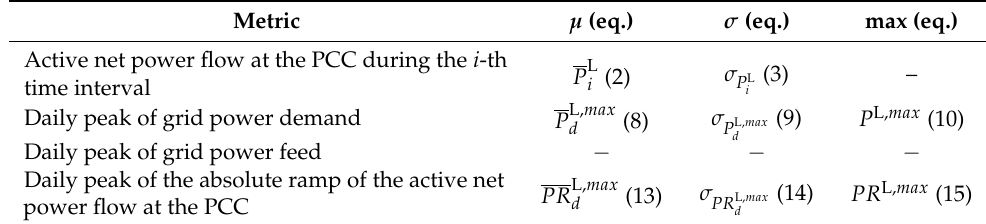
Table 3. Summary of the metrics and reference to the related equations adopted to analyze the net power profiles at the PCC with the utility for Scenario A, i.e., without PV and storage. µ : average value, σ : standard deviation, max: maximum value. Metric µ